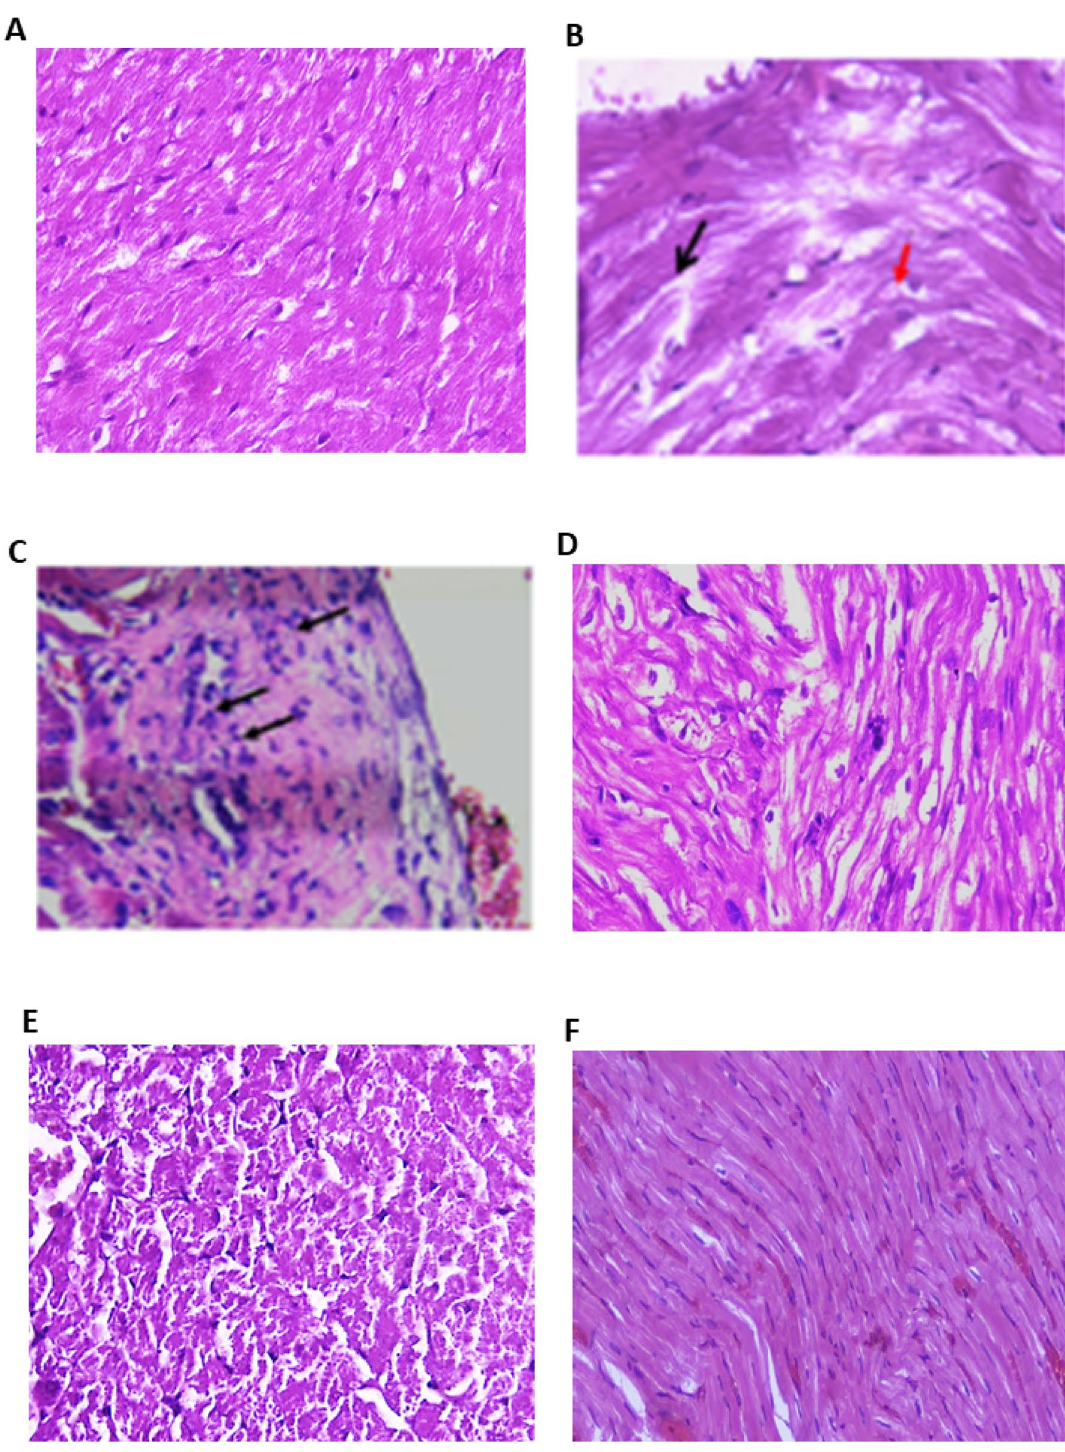
Figure 1. Photomicrograph of heart tissue sections in different studied groups. (H&E). ( A ) Control group showed normal myofibrillar structure with striations, ×200; ( B ) model group (dexamethasone-treated group) showed muscle separation (black arrow) with some vacuolated cells (red arrow) to myositis with scattered inflammatory cells (arrows) surrounding dilated blood vessels with stromal edema (×400); ( C ) PRV 0.5 mg/kg group showed slight separation of the cardiac muscle (black arrow), vacuolization of some cells (red arrow), and scattered few inflammatory cells; ( D ) PRV 1 mg/kg group showed greater improvement of the histopathological picture, except for muscle separation; ( E ) PRV 2 mg/kg group showed congested myocardium reverted to a nearly normal histopathological appearance; ( F ) losartan-treated group showed partial loss of cardiac muscle striations and occasional muscle separation